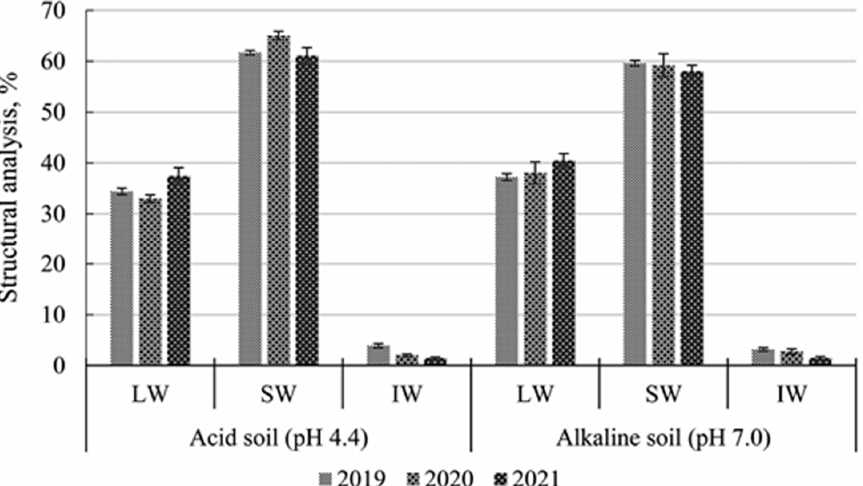
Figure 2. Comparison of stem weight (SW), leaf weight (LW), and inflorescence weight (IW) mean values of alfalfa populations grown on acidic and alkaline soil. Vertical dashes indicate the mean of standard error.